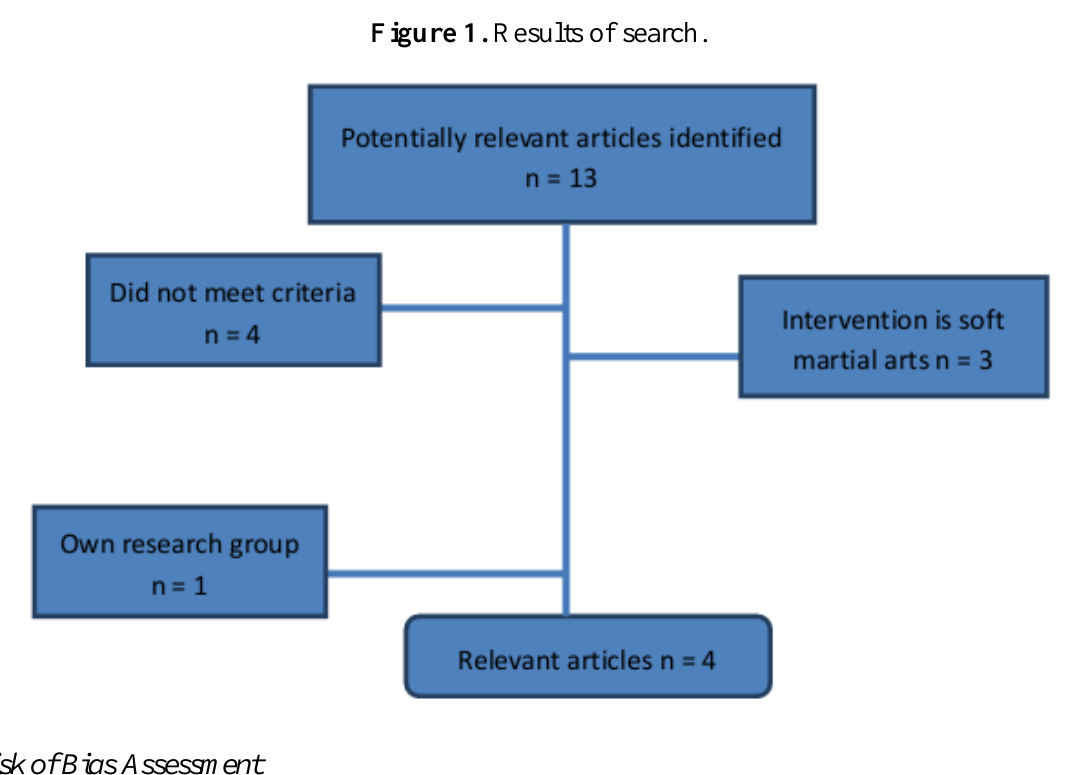
Figure 1. Results of